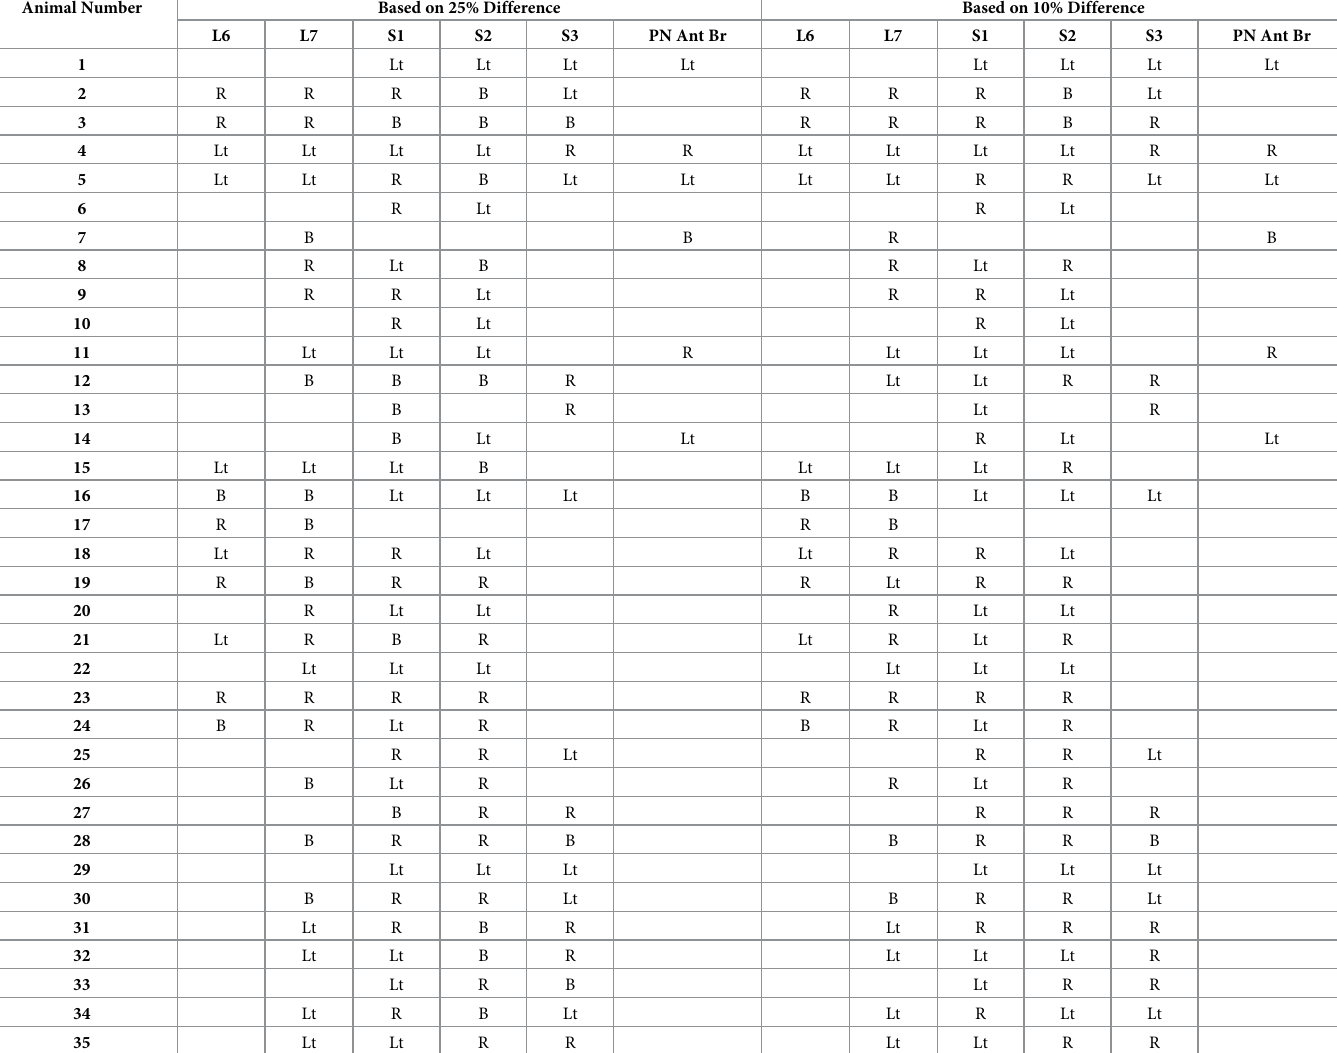
Table 2. Lateralization of 35 dogs that underwent multiple segmental testing, based on the 25% and 10% differences between left and right stimulated spinal roots (L6-S3) and the pelvic nerve’s anterior vesical branch. Animal